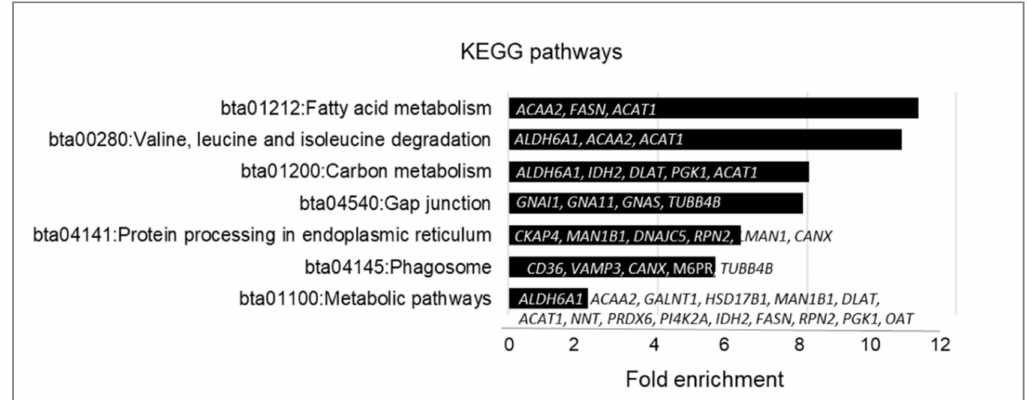
Figure 5. Enrichment analysis of biological pathways GO terms of the genes coding palmitoylated proteins, identified in bovine ovarian follicular cells, performed using DAVID 6.8 (https://david.ncifcrf.gov/home.jsp, accessed on 10 March 2021). Only significantly enriched KEGG pathways are